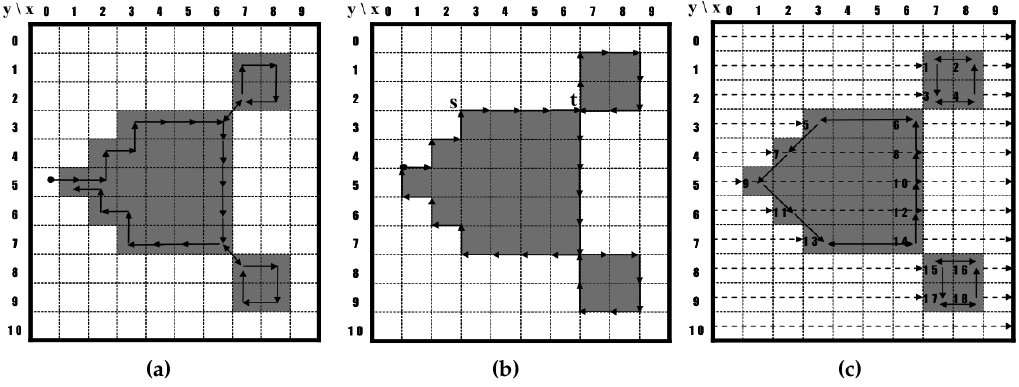
Figure 1. Category of contour tracing algorithms. ( a ) Pixel-following algorithm; ( b ) vertex-following algorithm; ( c ) run-data-based following